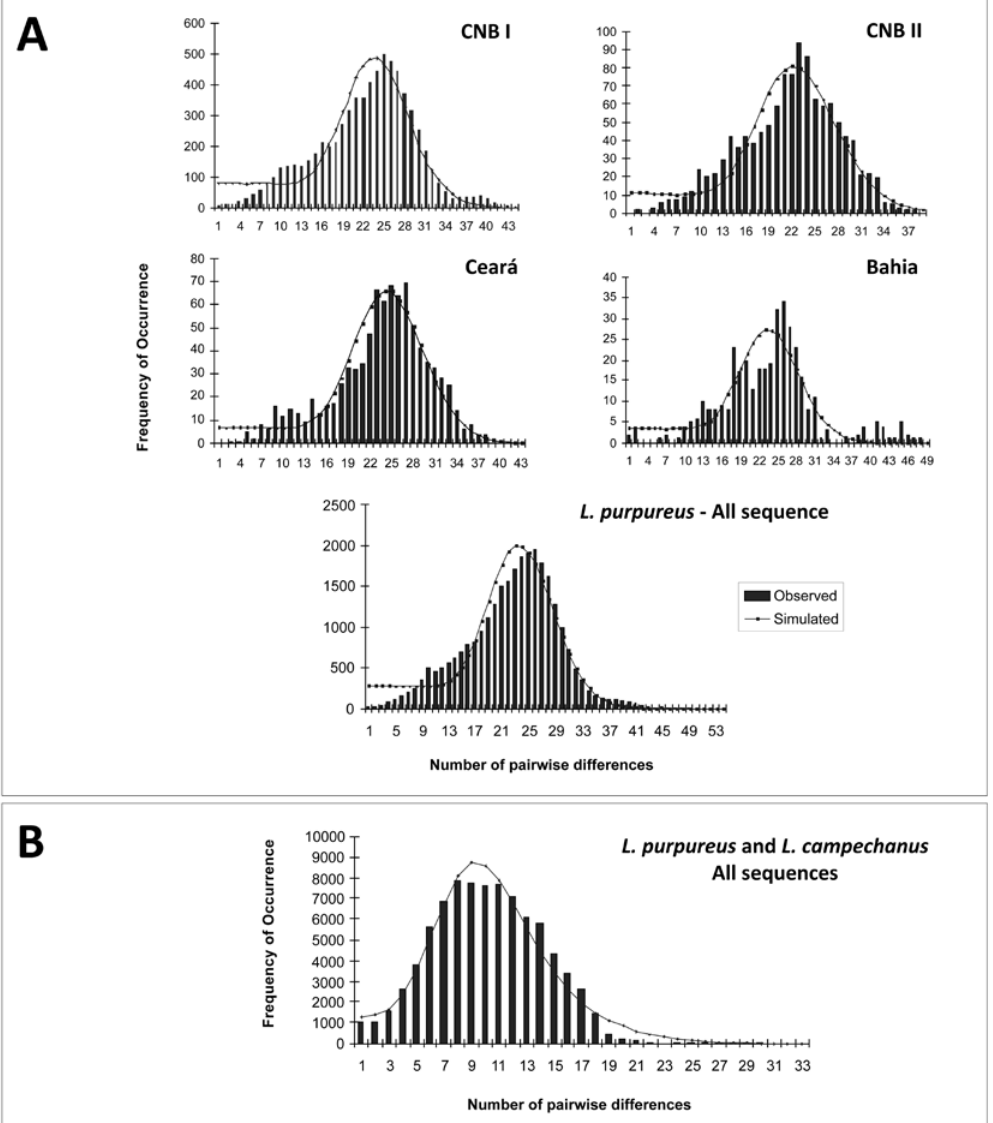
Fig. 4 - Distribution of pairwise differences between haplotypes based on sequences of the mitochondrial control region in: (A) L. purpureus from four Brazilian localities (CNBI, CNB II, Ceará, and Bahia) and all sequences, and (B) L. purpureus and L. campechanus (n = 414) from the western